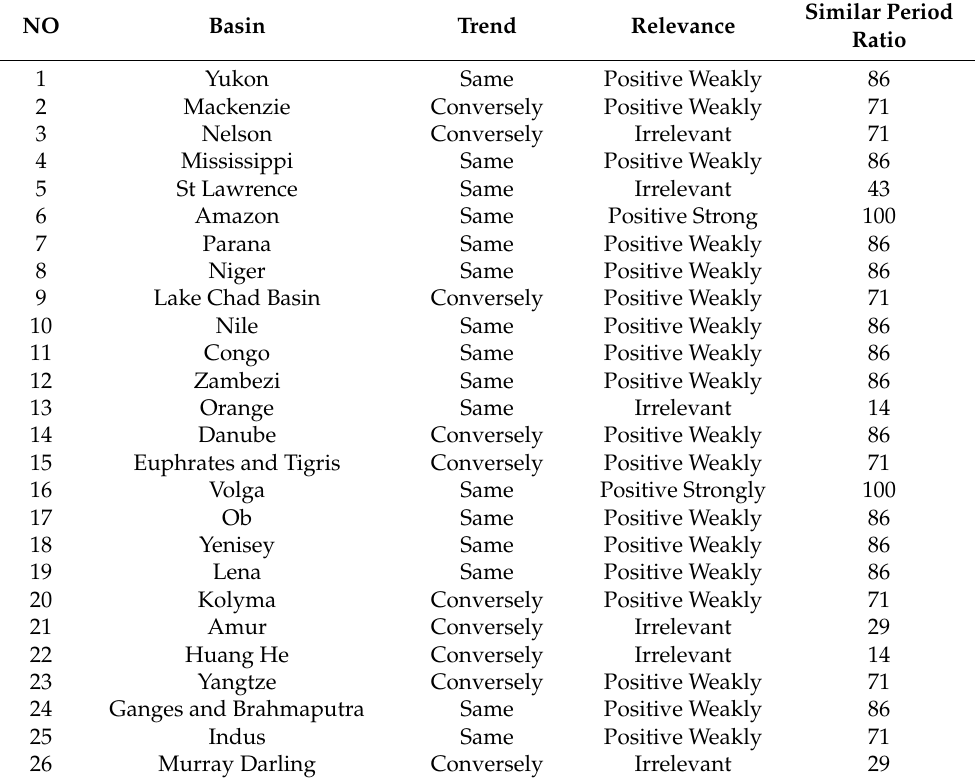
Table 17. Statistics of accuracy indicators of Swarm-TWSC in 26